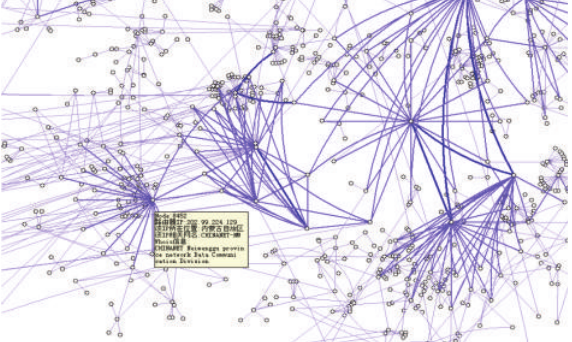
Figure 6: The whole display of the network logical topology in